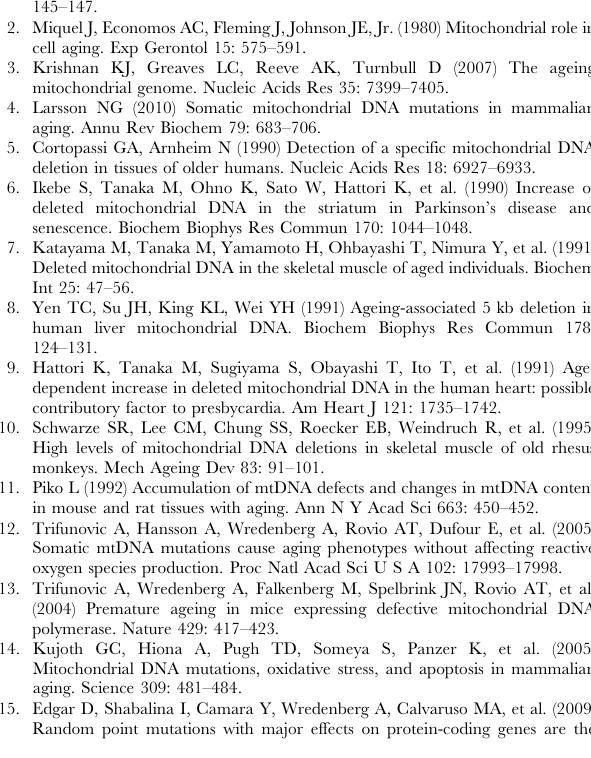
Table S4 Small indels ( , 10 bp) observed in the samples by the SplitSeek method.